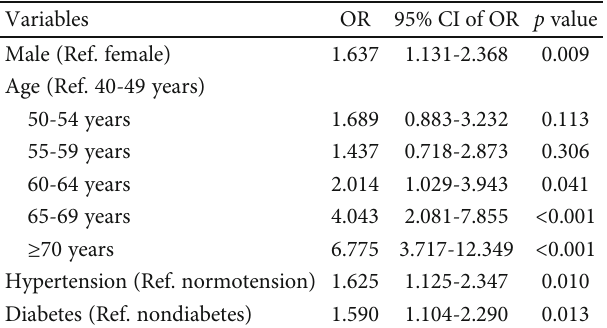
Table 4: Predictors of carotid